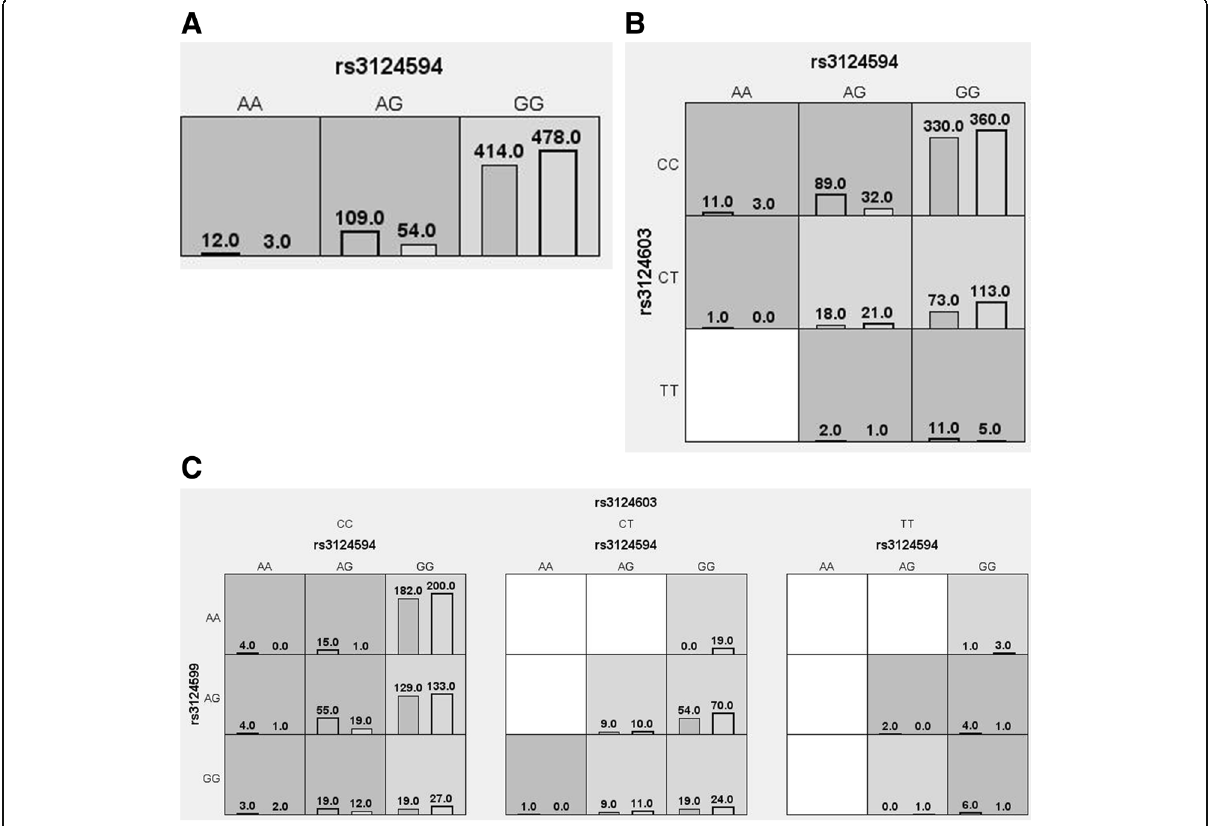
Fig. 2 Graph model of the interaction between the three SNPs ( a : rs3124594 model, b : rs3124594-rs3124603 model, c : rs3124594-rs3124599- rs3124603 model). Dark gray and light gray boxes presented the high- and low-risk factor combinations, respectively. Left bars within each box represented case while the right bars represented control. The heights of the bars are proportional to the sum of samples in each